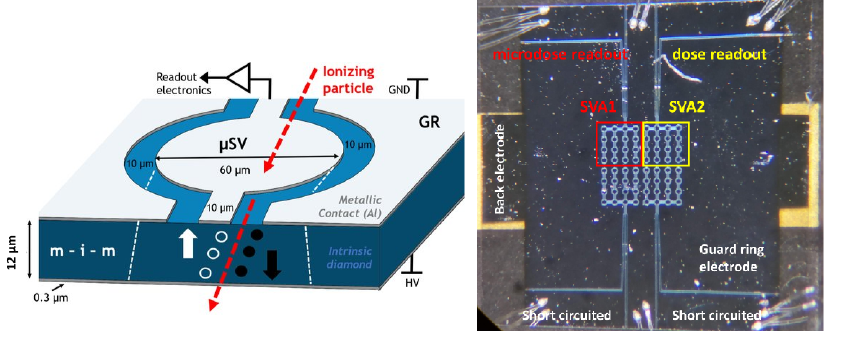
Figure 1. Left: the schematic representation of one microsensitive volume µ SV of diamond GR microdosimeter prototype. Right: an optical micrograph of the diamond membrane with four sensistive microSVs arrays showing the µ SVs marked with red (for microdosimetric read-out) and yellow (dose read-out)